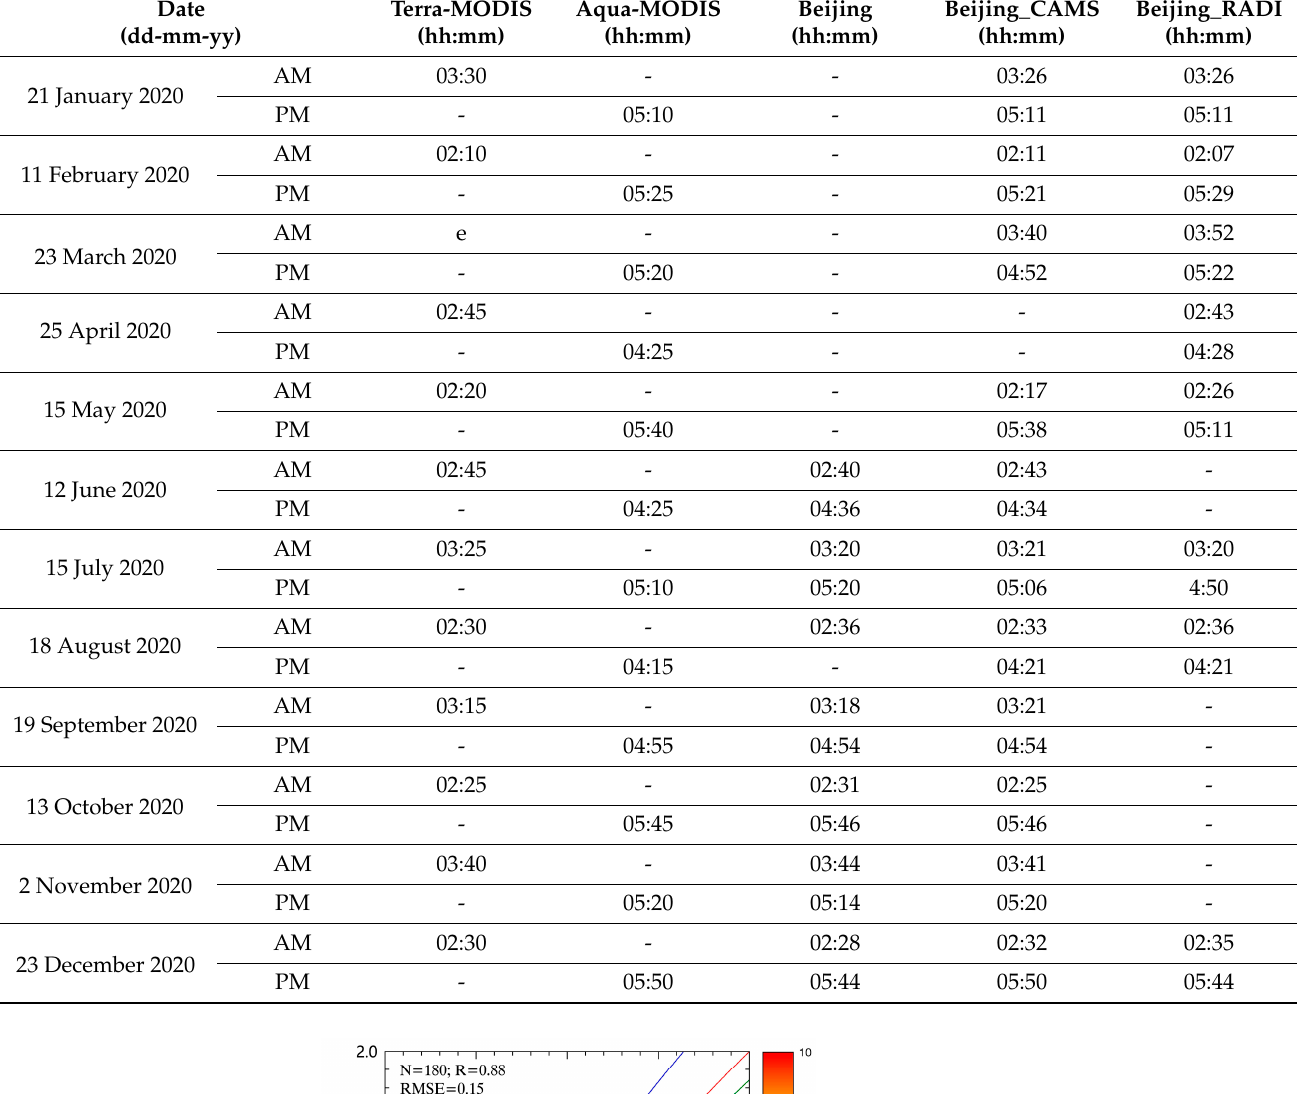
Table 2. Observation times of satellite and ground-based data for AOD retrieval (Take any two days of each month as an example).